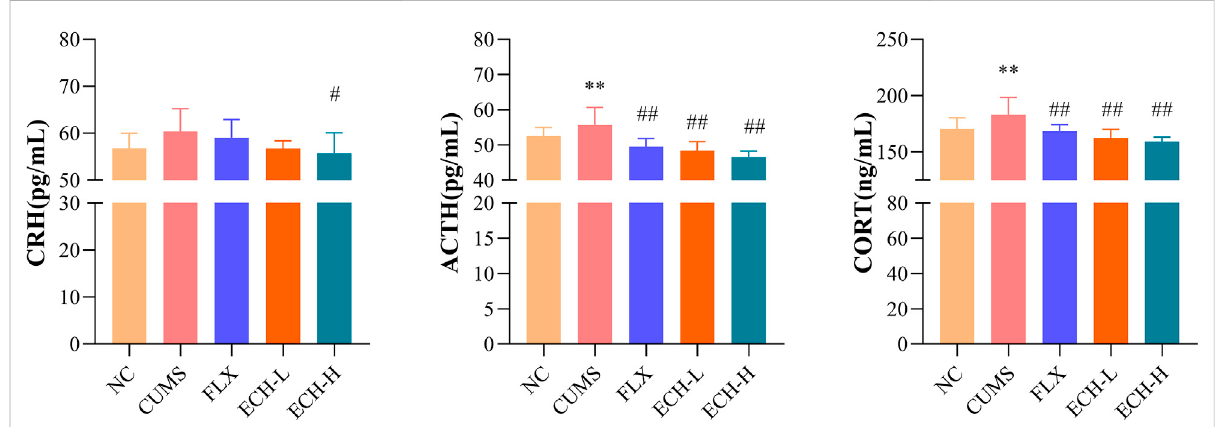
FIGURE 4 Effects of ECH on CRH, ACTH and CORT levels in the serum of CUMS Mice. NC, un-treated normal mice; CUMS, mice were treated with the chronic stimulating factors for 7 weeks to set up the CUMS depression model; FLX, CUMS induced mice were administered with fl uoxetine (10 mg/kg,i.g.) daily for 21 days; ECH-L, CUMS induced mice were administered with echinacoside (15 mg/kg,i.g.) daily for 21 days; ECH-H, CUMS induced mice were administered with echinacoside (60 mg/kg,i.g.) daily for 21 days n = 8/group. * p < .05, ** p < .01 compared with control group; # p < .05, ## p < .01 compared with CUMS group.